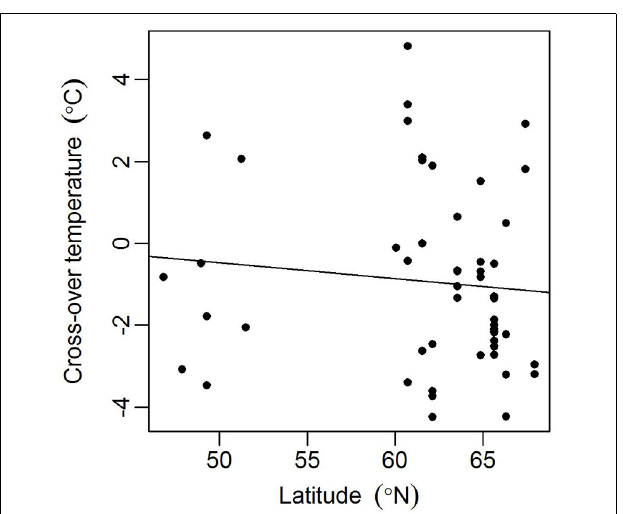
FIGURE 5 | Association between the latitude of origin and estimated tree-specific cross-over temperature c i for spruces in the spring (2012 needles). Spearman’s rank correlation ρ = − 0 . 23 ( p = 0 .